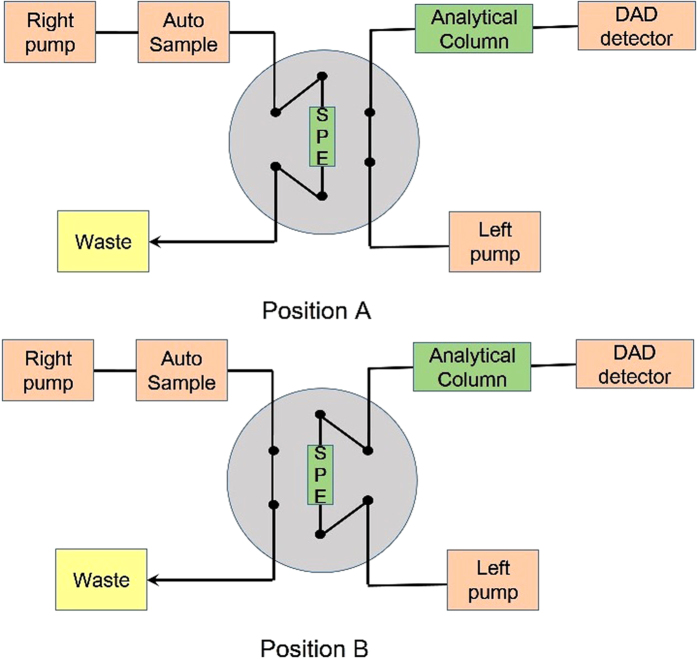
The schema for online SPE-HPLC setup.